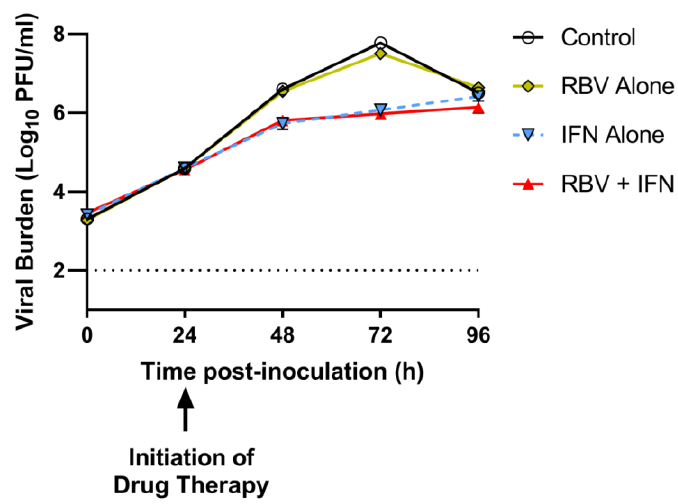
Figure 3. Antiviral activity of clinical exposures of interferon- α (IFN) and/or ribavirin (RBV) after 24 h post-infection (p.i.) in the Hollow fiber infection model (HFIM) system. Huh-7 cells were mixed with DENV2 at a multiplicity of infection of 0.001 PFU/cell and inoculated into the HFIM system. After 24 h post-inoculation, cells were exposed to RBV and/or IFN at levels corresponding to the clinical regimen. Supernatants were collected from the system for three days after the start of drug administration. Viral burden was quantified by plaque assay in Vero cells and is described as log 10 PFU/mL. Each data point represents the geometric mean of two independent samples and error bars (smaller than symbols and, thus, not visible) correspond to one standard deviation. The dashed horizontal line represents the assay limit of